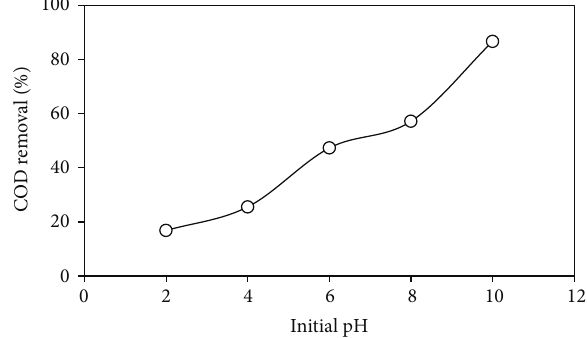
Figure 6: Effect of pH on photodegradation of DIPA using Cu- Ni/TiO 2 photocatalysts (photocatalysts loading = 1g ⋅ L −1 ; DIPA concentration = 100 ppm; irradiation time = 1h).